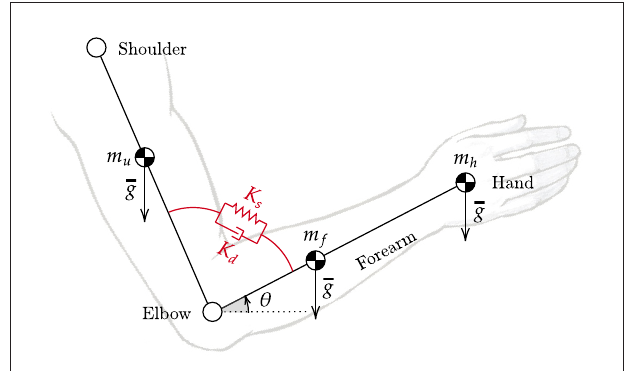
FIGURE 3 | Impedance model at the elbow joint. The unified controller implements virtual stiffness and damping (in red) at the elbow joint. The elbow joint is rendered as a second-order system mass-spring-damper. The equilibrium point of the spring continuously changes according to the desired trajectory ( θ